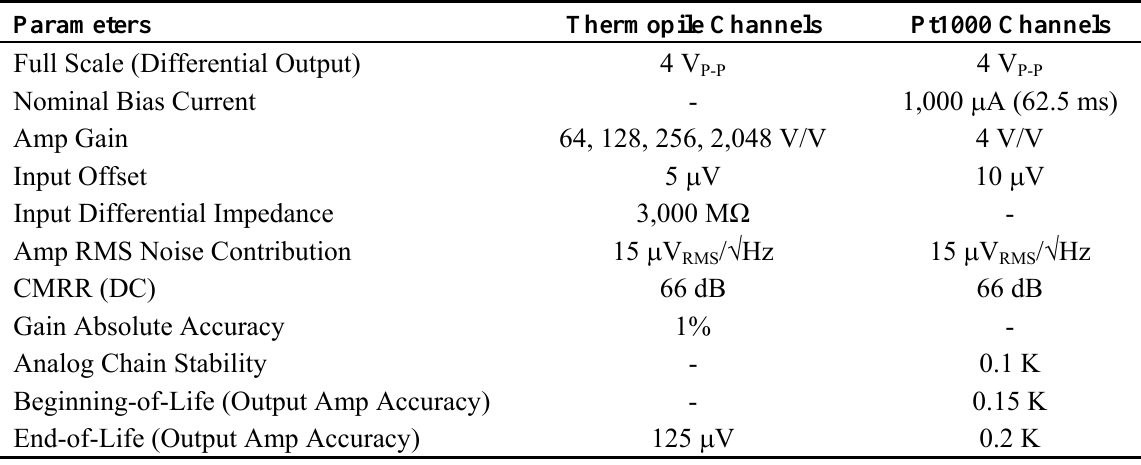
Table 4. ASIC amplifier